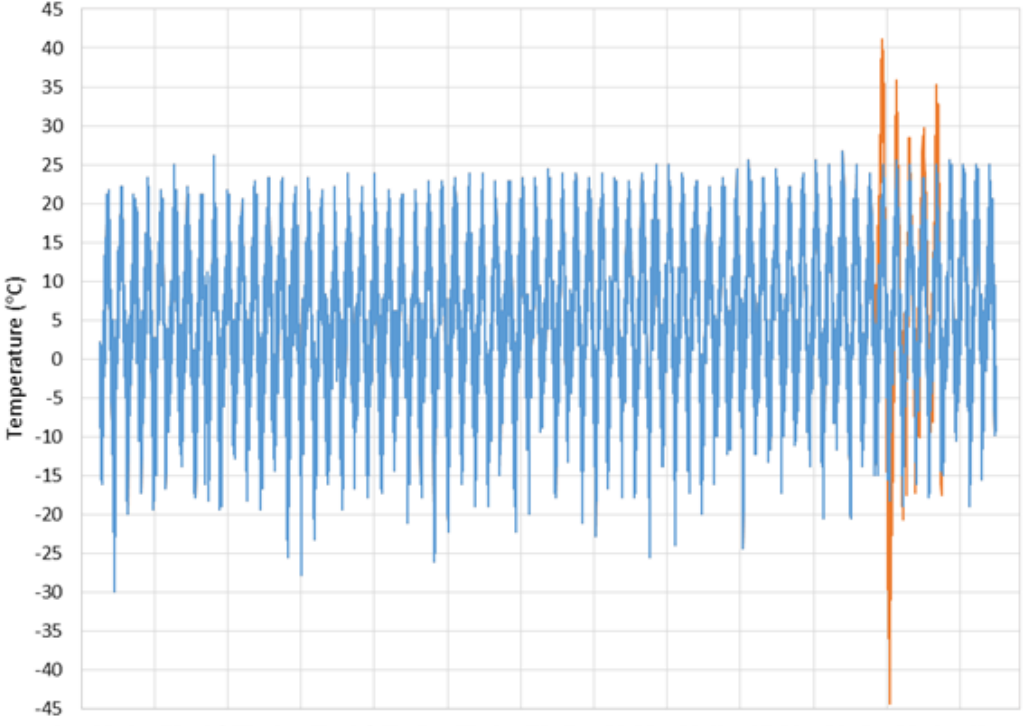
Figure 11. The 3-year gap realization with the worst Root Mean Squared Error (RMSE) value, 8.64. This plot shows the full observed record to show that the imputed data from this realization significantly exceed the observed data limits. This issue could easily be identified using algorithms.